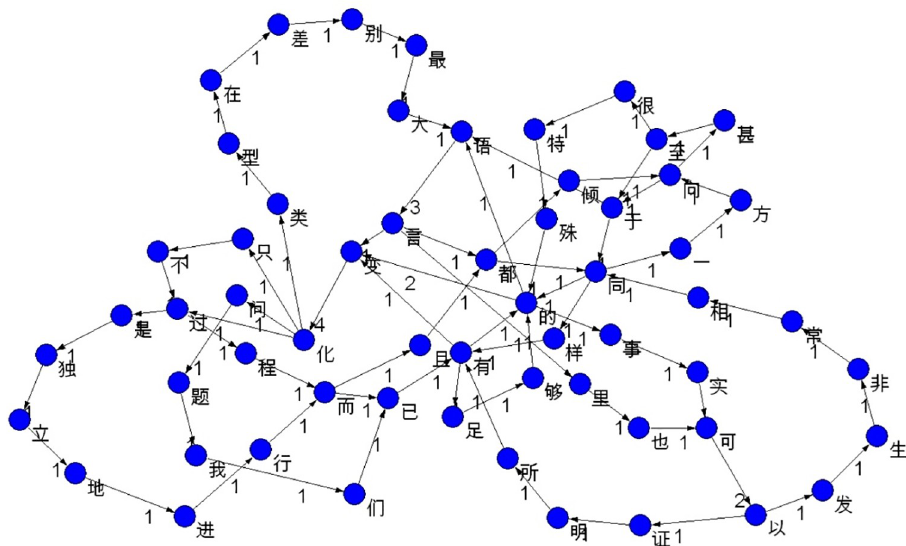
Fig 2. A linguistic network based on the text of Example